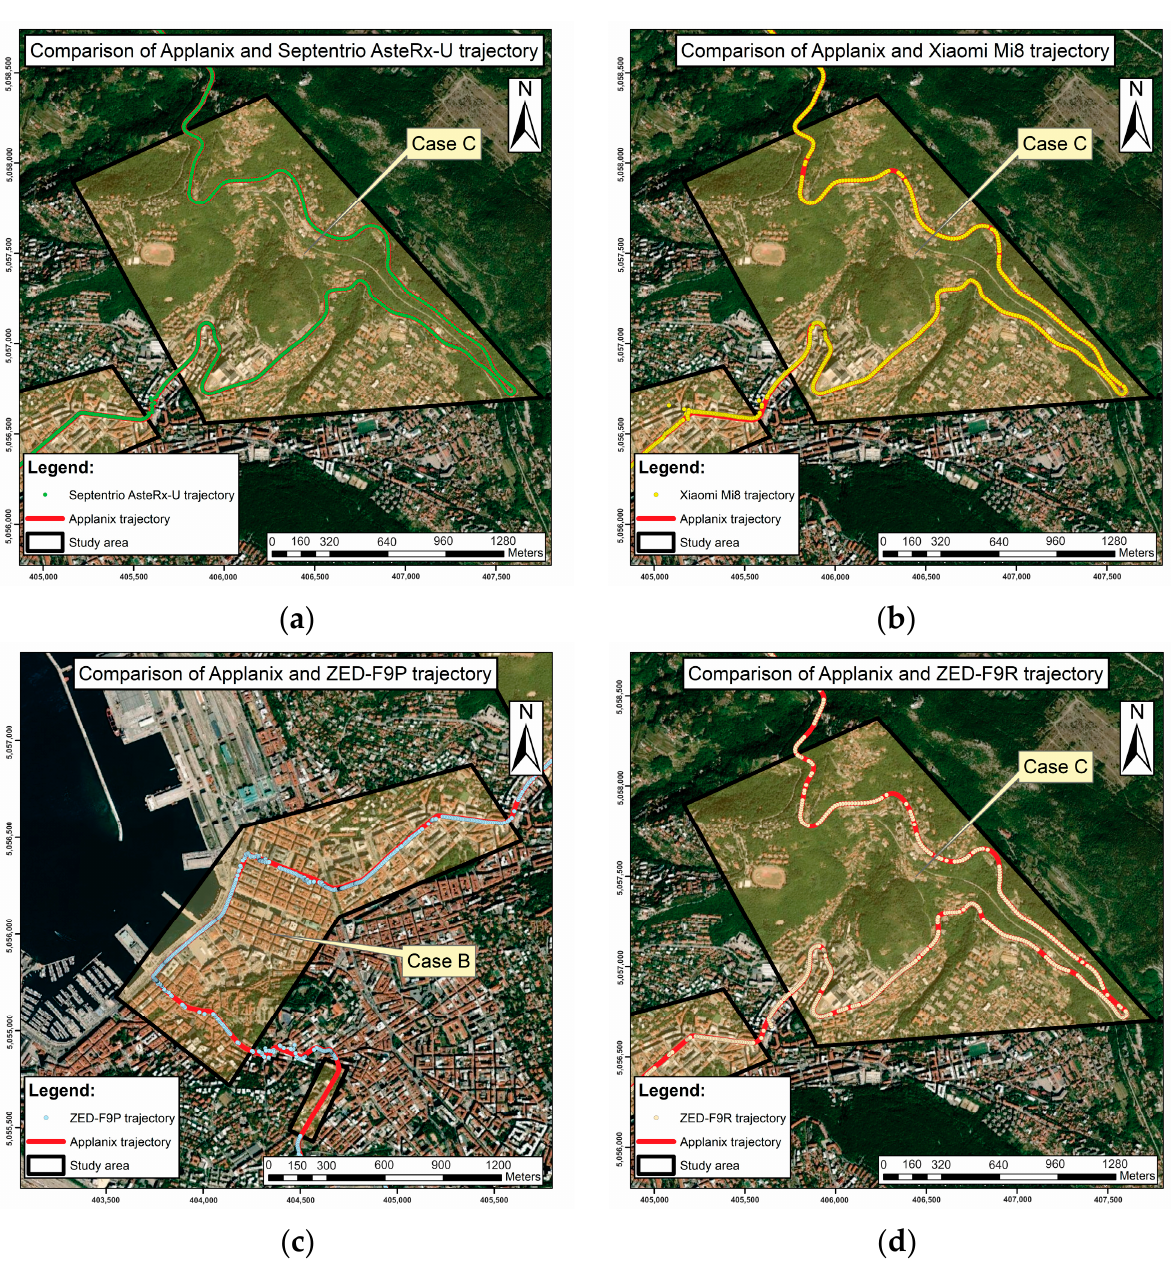
Figure 13. Case C: performance of: ( a ) Septentrio AsteRx-U, ( b ) Xiaomi Mi8, ( c ) u-blox ZED-F9P, and ( d ) u-blox ZED-F9R.